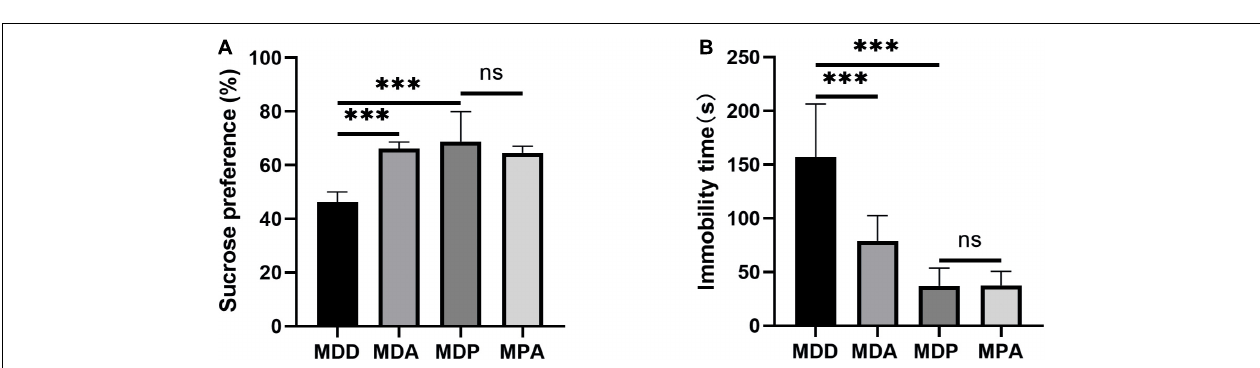
FIGURE 11 | Atrial fibrosis and the expression of related proteins. (A) Typical images of Sirius red staining. (B) Percentage of the fibrosis area of the four groups, n = 6 per group. (C) Immunoblotting of TGF- β 1 and COL1. (D,E) Quantitative analyses of TGF- β 1 and COL1, n = 5 per group. ** p < 0.01, *** p < 0.001 vs. CTL; # p < 0.05, ## p < 0.01, ### p < 0.001 vs. MDD.